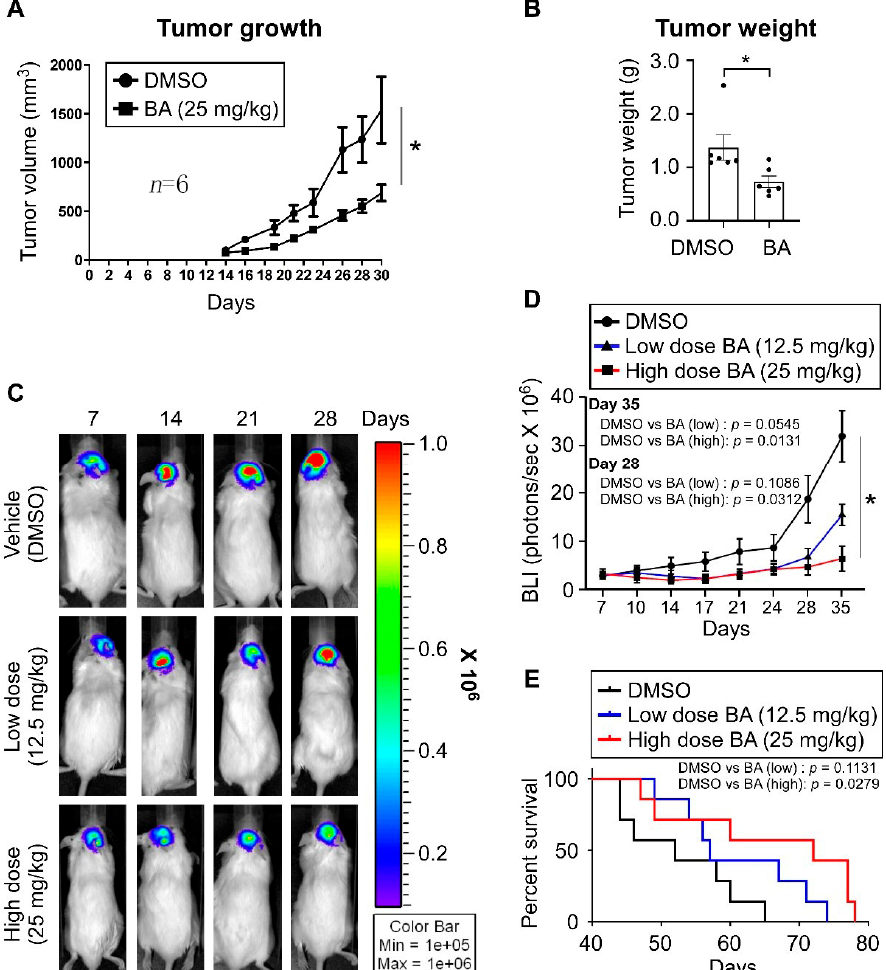
Figure 7. BA enhances therapeutic efficacy and long-term survival in GBM xenograft model mice. ( A , B ) TMZ-resistant U87MG cells implanted subcutaneously in NOD / SCID mice. On Day 4 after transplantation, mice were randomly grouped and treated with DMSO or BA for 4 weeks. ( A ) Tumor volume (length × width 2 × 3.14 / 6) was measured three times a week. After treatment, mice were sacrificed. ( B ) Tumor weights. ( C – E ) Established orthotopic GBM xenograft animal model from luciferase + GFP dual-labeled U87MG cells (2.5 × 10 5 cells / mouse). Mice were treated with DMSO or BA at different doses three times a week. ( C , D ) Tumor growth monitored using in vivo image system (IVIS) twice a week. ( E ) Survival plotted using Kaplan–Meier curves. ( A,B,D ) Data presented as means ± standard deviations (t-Test: * p <